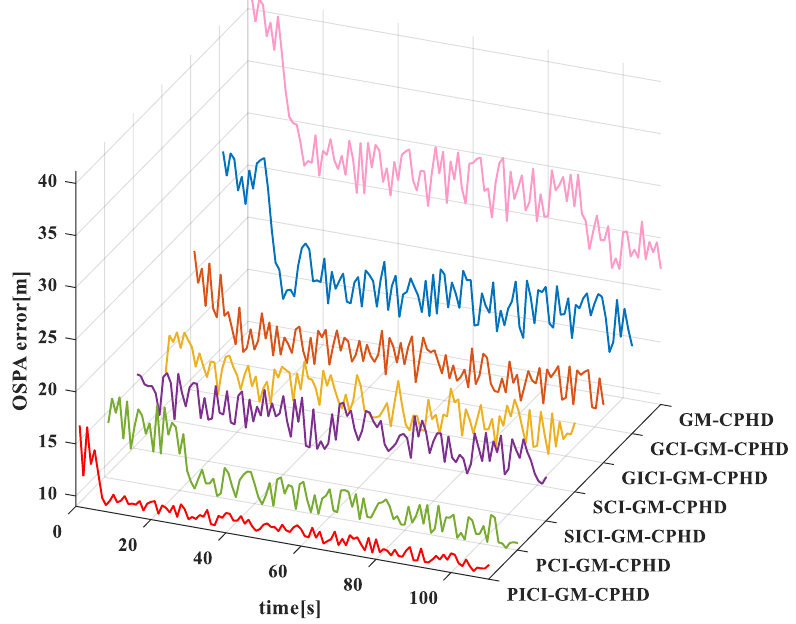
Figure 8. Comparison of OSPA distance errors of several algorithms in linear models.